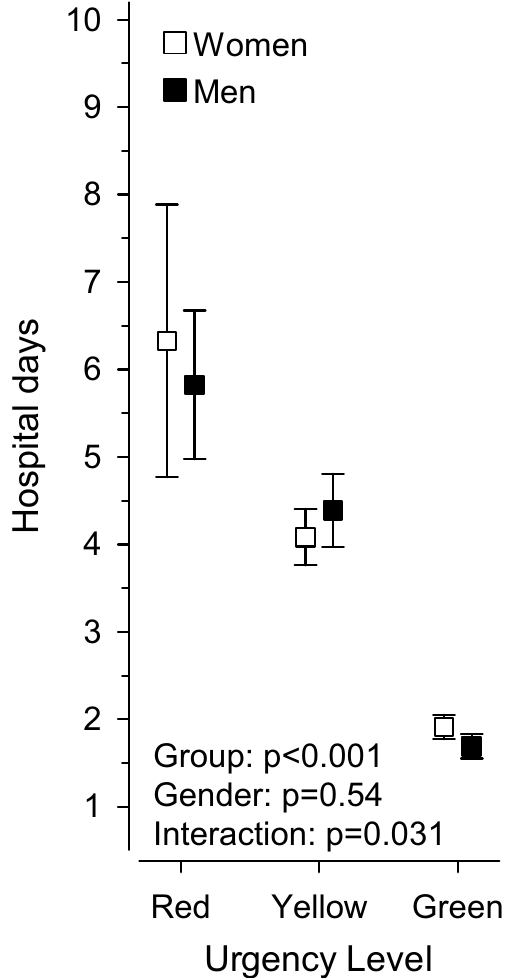
Figure 1. Mean length of hospital stay (days). Urgency of emergency operation: red = 0–8 h; yellow = 8–48 h; green = 2–14 days. Whiskers represent 95% confidence